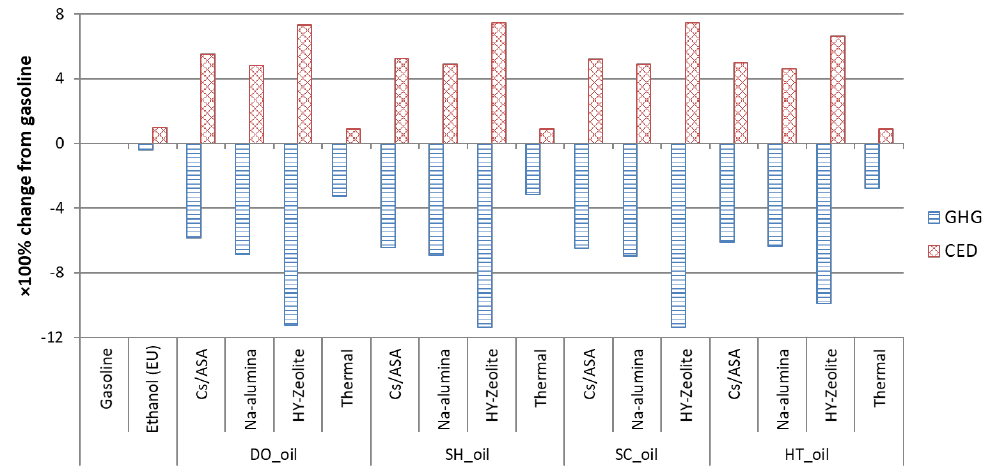
Figure 6. Comparison of the CED and GHG emissions of pyrolysis biofuel from four cases and four scenarios with ethanol and gasoline.